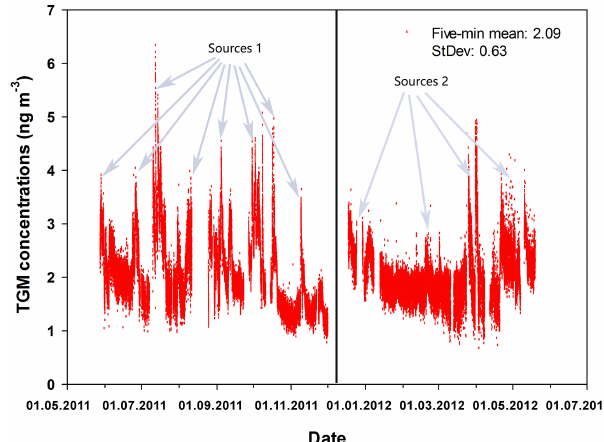
Figure 2. Total gaseous mercury (TGM) concentration in the am- bient air at ALS. Source 1 represents the peaks of high TGM con- centrations at ALS during the ISM period, which were caused by anthropogenic Hg emissions from inland China due to the strength- ening of EASM. Source 2 represents the peaks of high TGM con- centrations at ALS during the non-ISM period, which were caused by the biomass burning from southeast Asia and anthropogenic Hg emissions from south